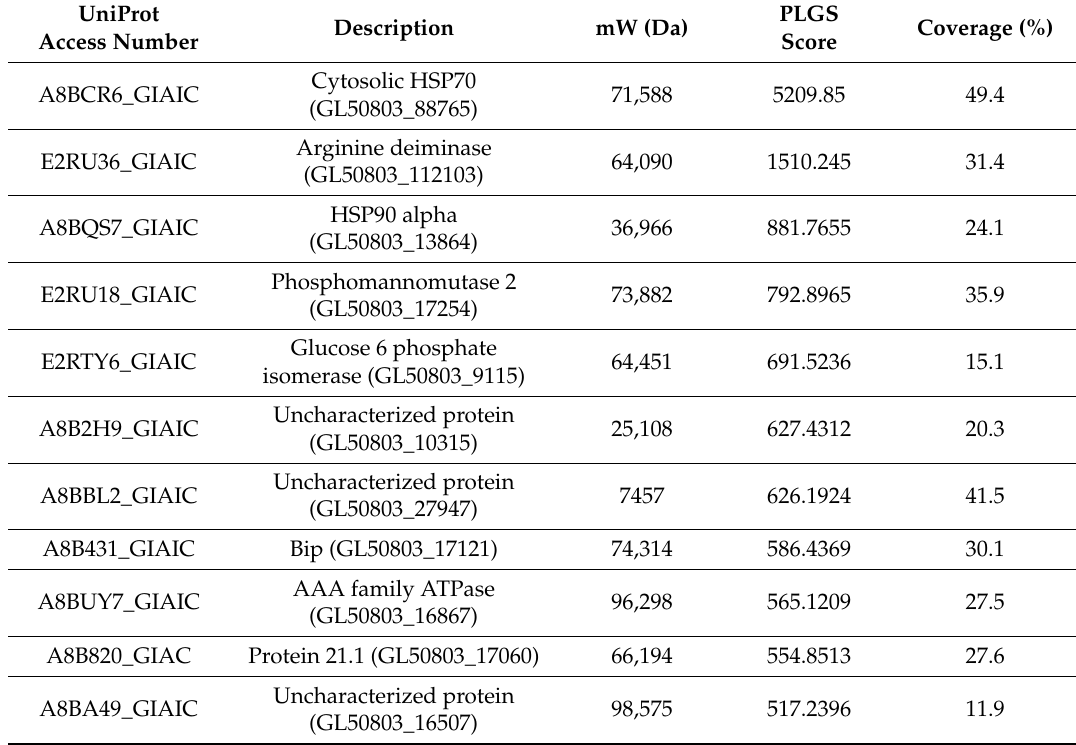
Table 2. Proteins identified in Giardia extract by UPLC-Q-TOF-MS after ASA treatment. UniProt Access Number